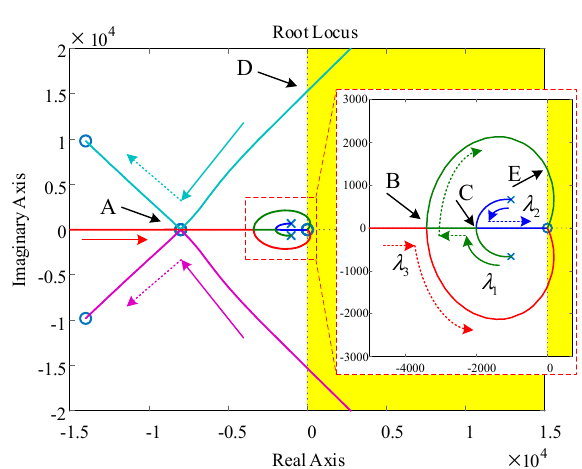
Φ ( ) s with different ρ . Figure 6. Root locus diagram of Φ r ( s ) with different ρ . r